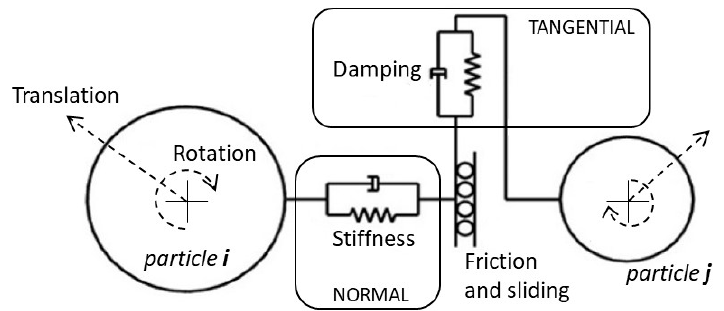
Figure 1. Schematic representation of the mechanics of the contact between two beads.